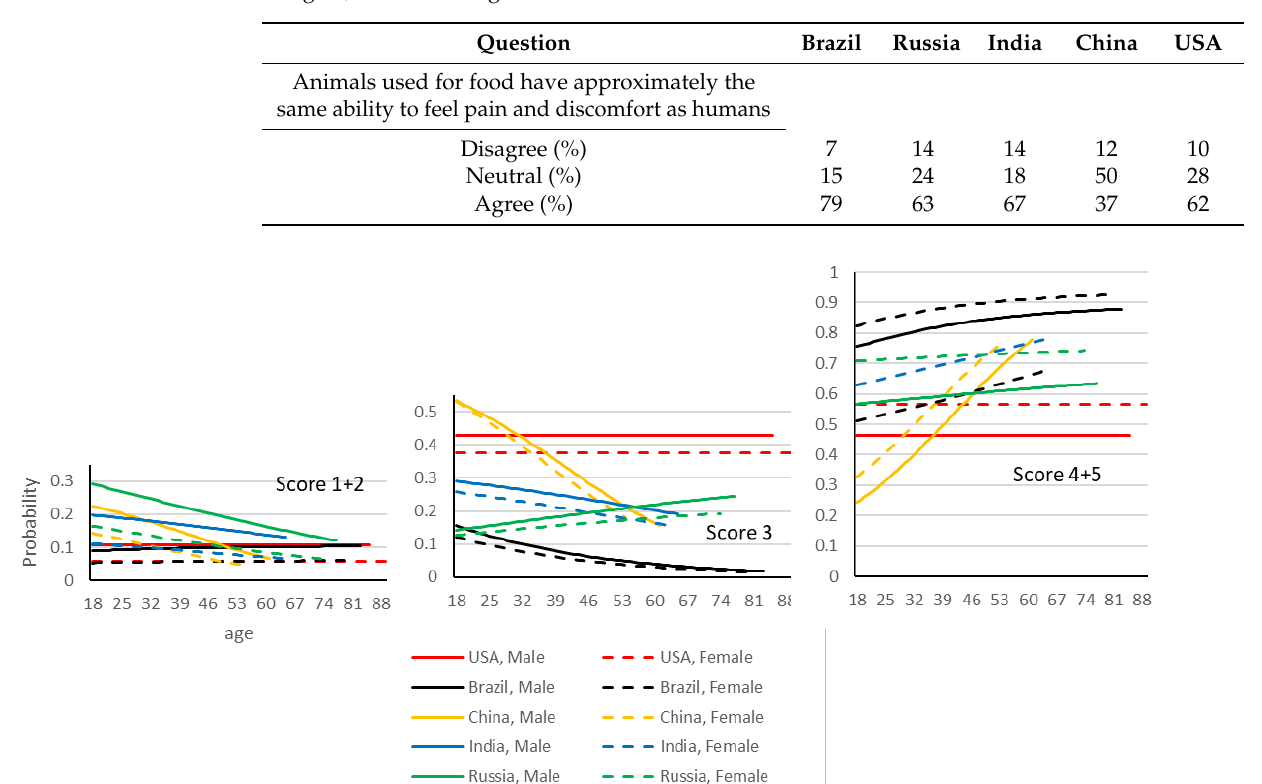
Figure 4. Graphical representation of the multinomial logistic model fitted to the data. The scores 1, 2 and 4, 5 are aggregated. Probabilities associated with disagreement scores (1 + 2), neither agree nor disagree score (3), and agreement scores (4 + 5) given to the statement “ animals used for food have approximately the same ability to feel pain and discomfort as humans ” .